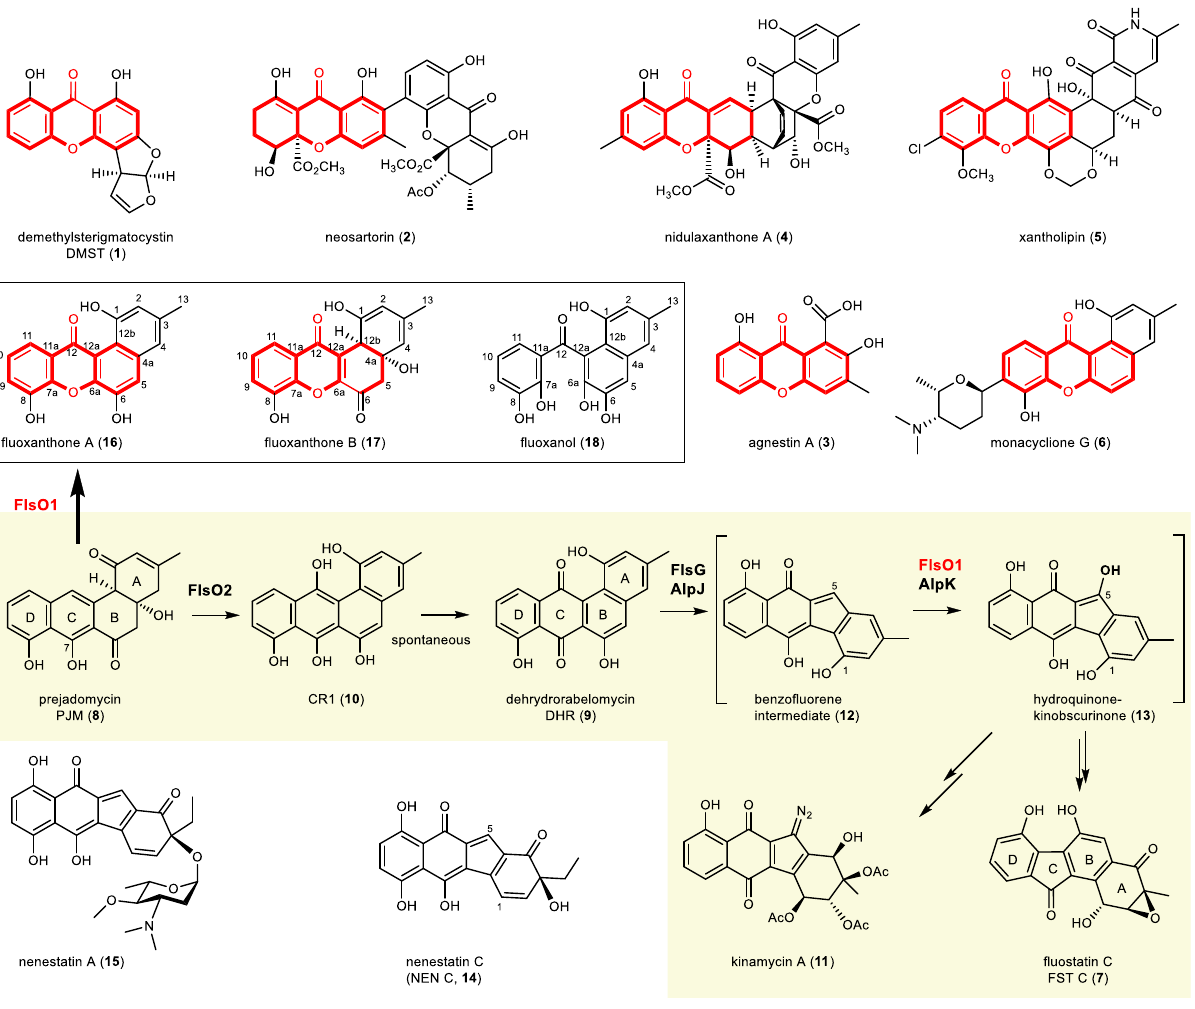
Fig. 1 | Typical xanthone-containing natural products and the proposed oxi- dative stepsin the biosynthesis ofatypicalangucyclines (yellow